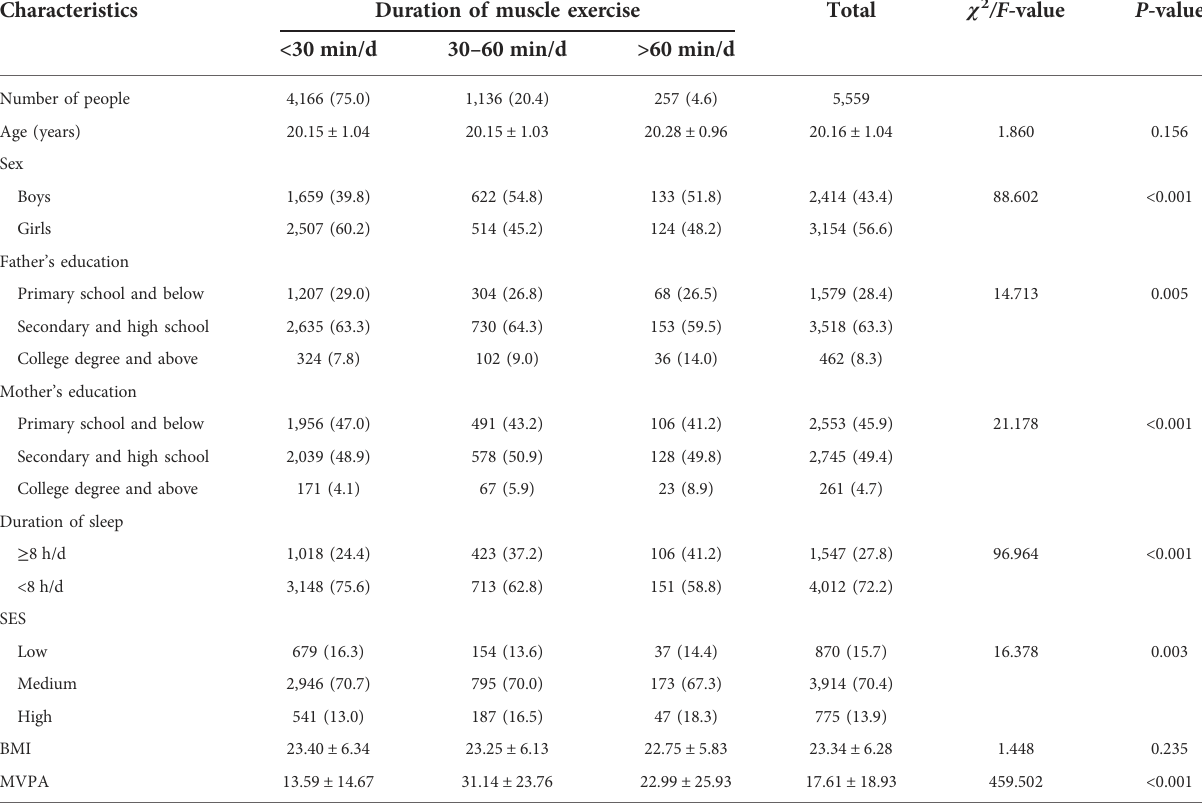
TABLE 1 Comparison of duration of muscle exercise among Chinese college students with different characteristics.